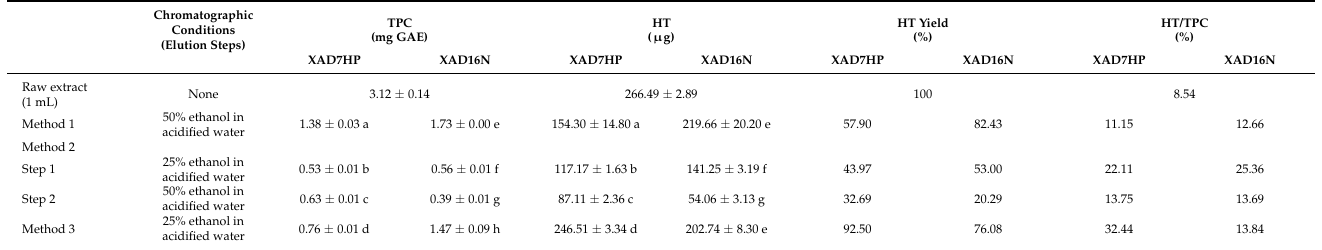
Table 1. HT purification on Amberlite XAD7HP and